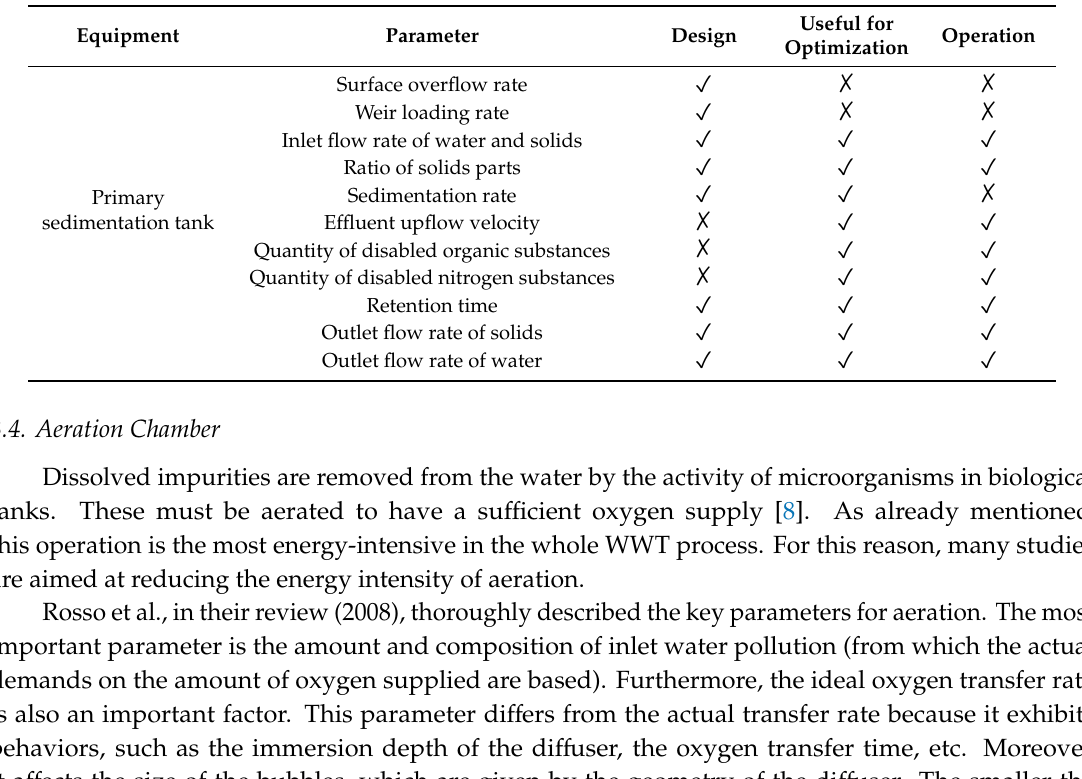
Table 3. Parameters of the primary sedimentation